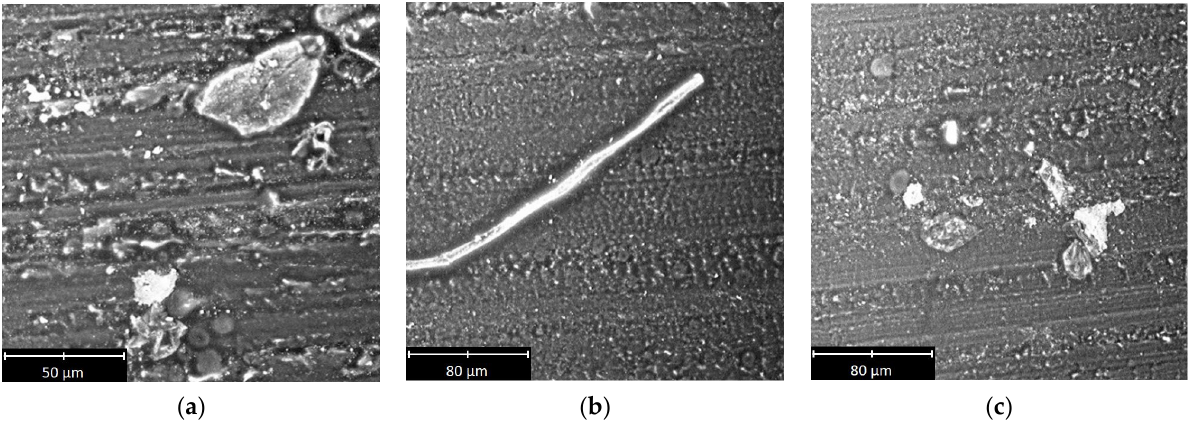
Figure 10. Selected SEM micrographs of sliding surface of PA6.